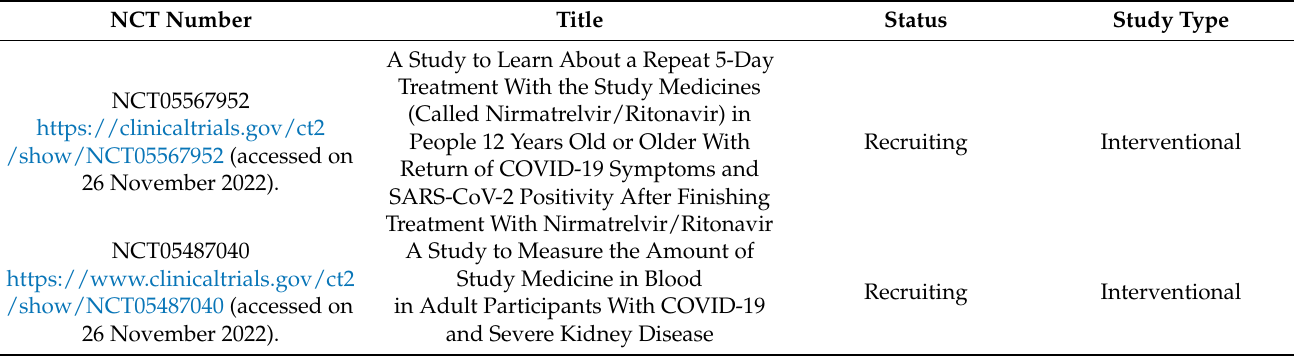
Table 1. Ongoing clinical trials on Paxlovid use that include pregnant and breastfeeding